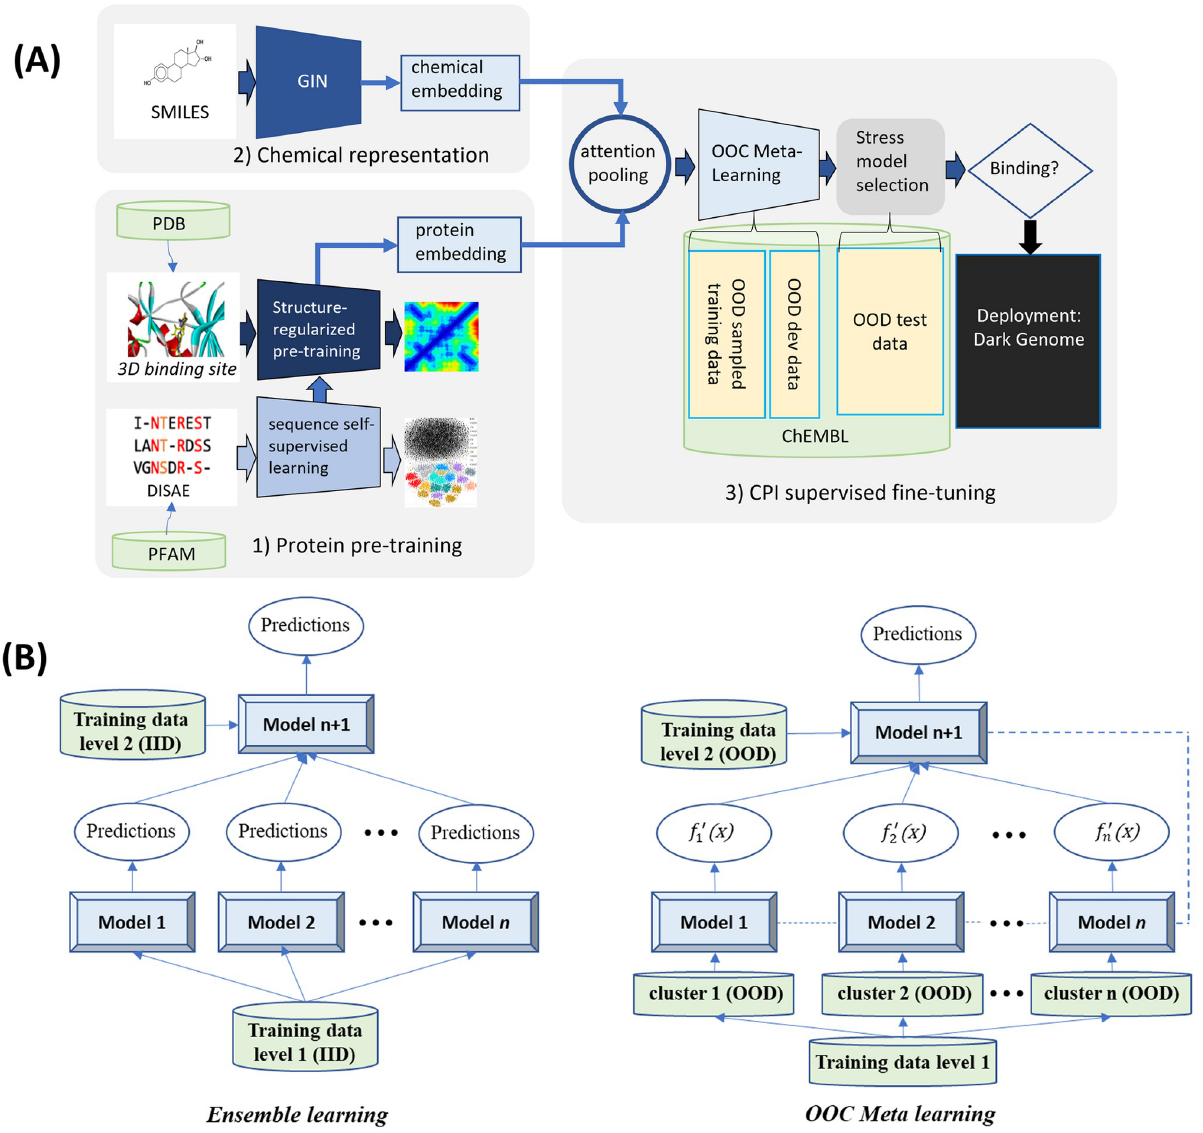
Fig 1. (A) Design Scheme of PortalCG: PortalCG enables the prediction of chemical-protein interactions (CPIs) for dark proteins, across gene families, via four key components: (i) ligand-binding site enhanced sequence pretraining, (ii) end-to-end transfer learning, in accord with the sequence- structure-function paradigm, (iii) out-of-cluster meta-learning (OOC-ML), and (iv) stress model selection. (B) How OOC-ML compares to classic stacking ensemble learning: OOC-ML is similar in spirit to stacking ensemble learning, but differs in data split strategies, model architecture, and optimization schema, as further detailed in the